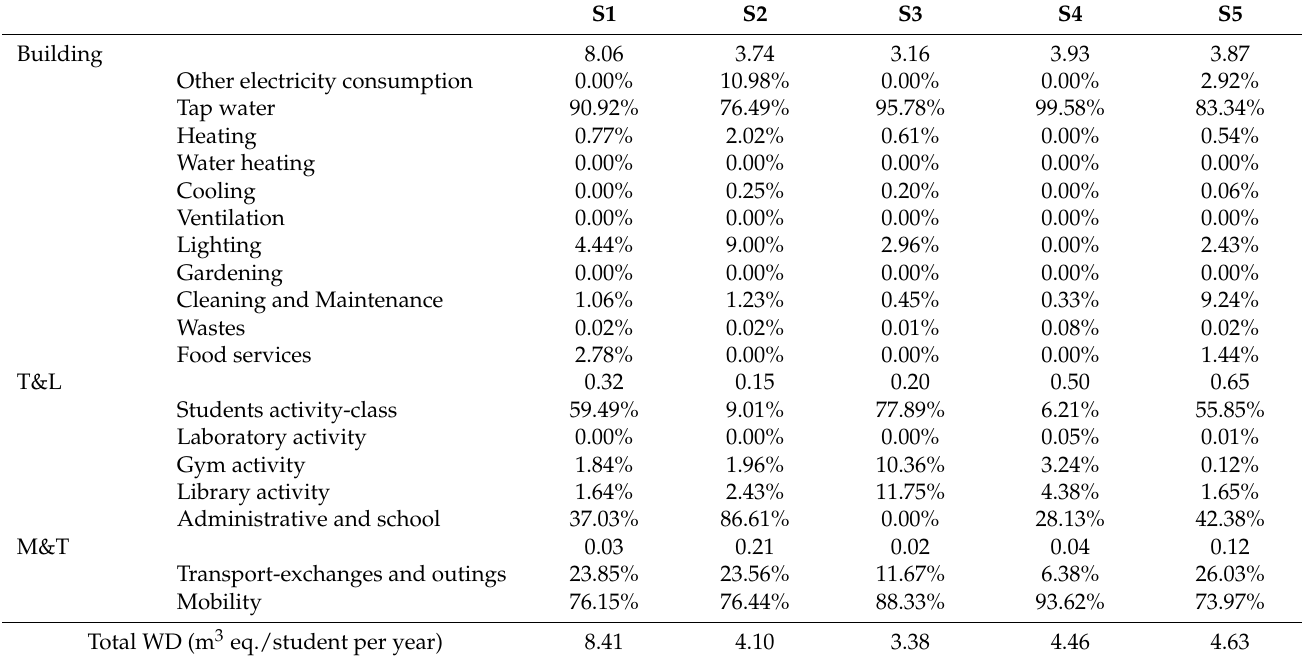
Table 7. Water depletion impacts results per school, subsystem, and activities.